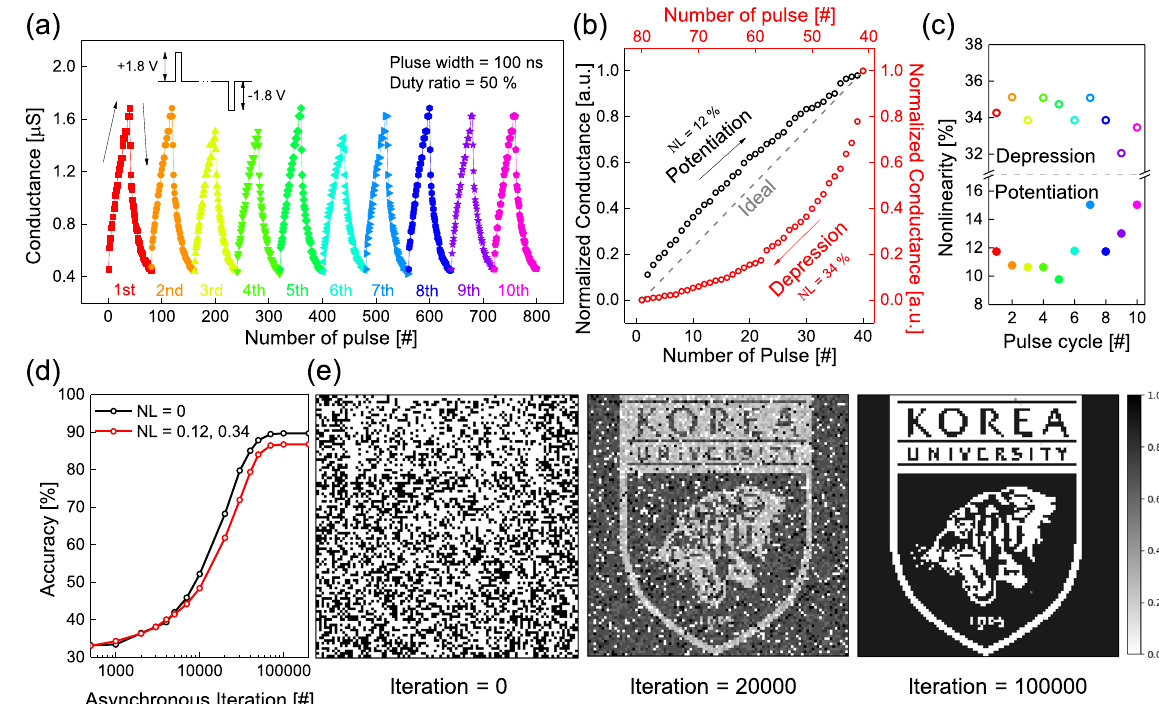
Figure 6. ( a ) 10 cycles and ( b ) normalized conductance of potentiation/depression synaptic plasticity of the Ag/a-SVO/Pt memristor. The nonlinear fitting curves can be described using the equation = + G n G A ( ) initial 1 τ τ − − + − − n A n [1 exp( / )] [1 exp( / )] . ( c ) NL values of the potentiation and depression processes. ( d ) The 1 2 2 simulated accuracy and ( e ) synaptic weight maps of a 100 × 100 binary image as a function of asynchronous iterations. Two schemes are calculated: the ideal case (NL = 0) and our device (NL = 0.12 and